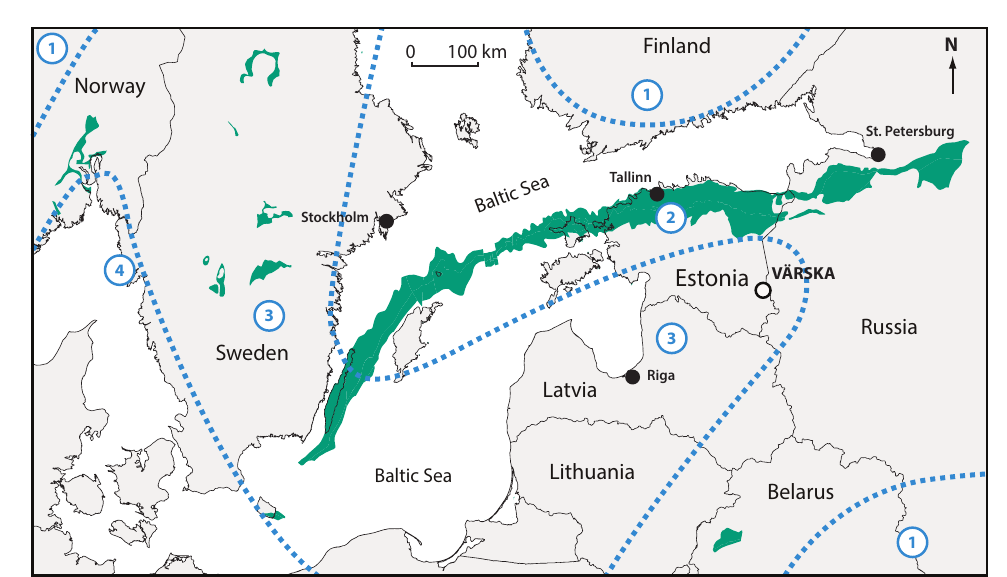
Fig. 1. Locality map showing the outcrop area of Ordovician rocks in the Baltic region (green) and schematic configuration of the Baltoscandian basin (after Männil 1966a and Nestor & Einasto 1997). 1, main land areas; 2, shallow­water Estonian shelf; 3, deeper­ water Livonian basin and Central Baltoscandian facies belt; 4, deep shelf of the Scanian facies belt (modified after Toom et al. 2019a).